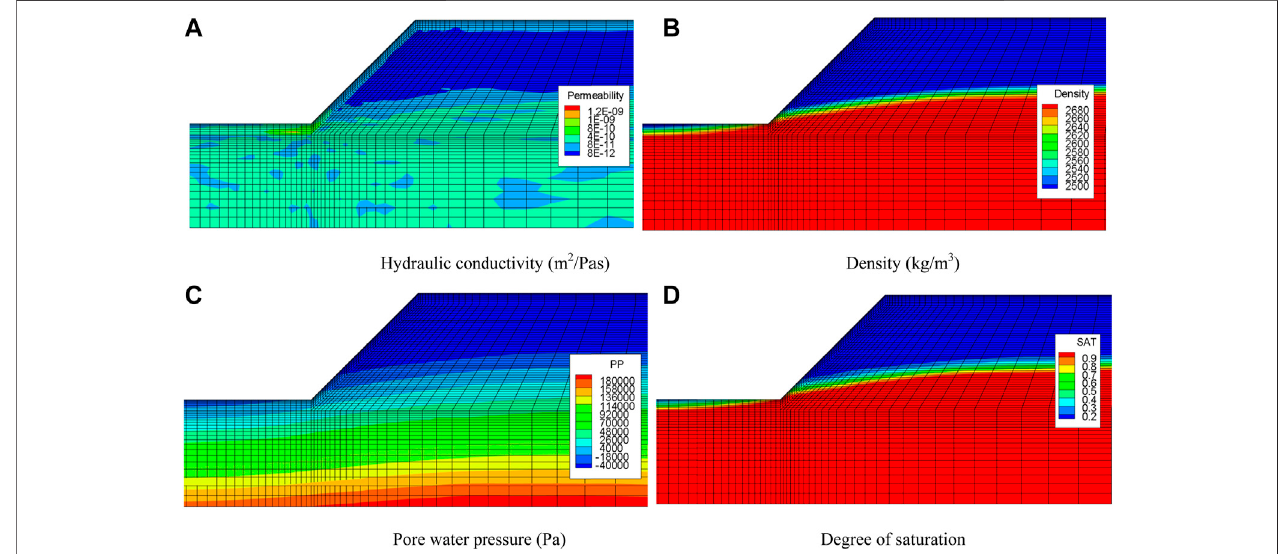
FIGURE 6 | Initial state of seepage random fi eld of rock slope: (A) Hydraulic conductivity, (B) Density, (C) Pore water pressure, (D) Degree of saturation.